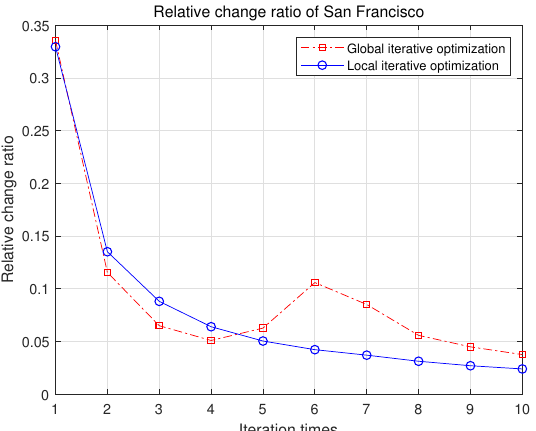
Figure 8. The relative change rate of the whole image and image blocks.